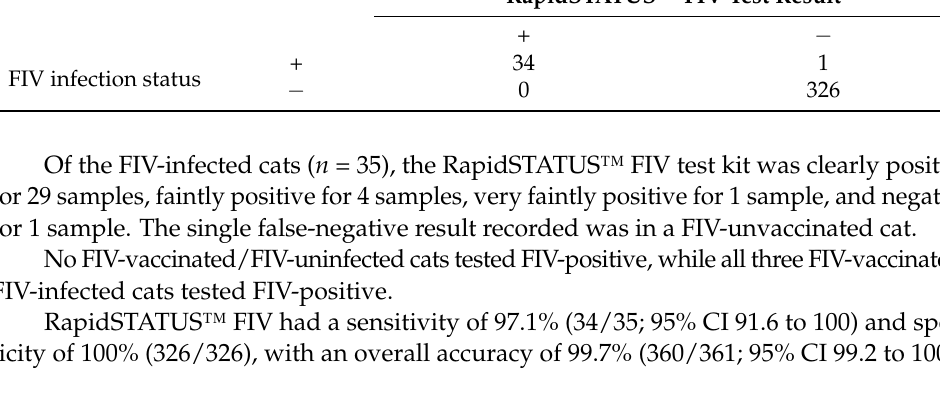
Table 1. Results from RapidSTATUS™ FIV testing in pet cats in Australia with a range of FIV vaccination/infection statuses ( n = 361). This comprised 57 FIV-uninfected cats annually vaccinated against FIV, 10 FIV-uninfected cats with lapsed FIV vaccination histories, 259 FIV-unvaccinated/FIV- uninfected cats, and 35 FIV-infected cats. RapidSTATUS™ FIV Test Result + − + 34 FIV infection status − 326